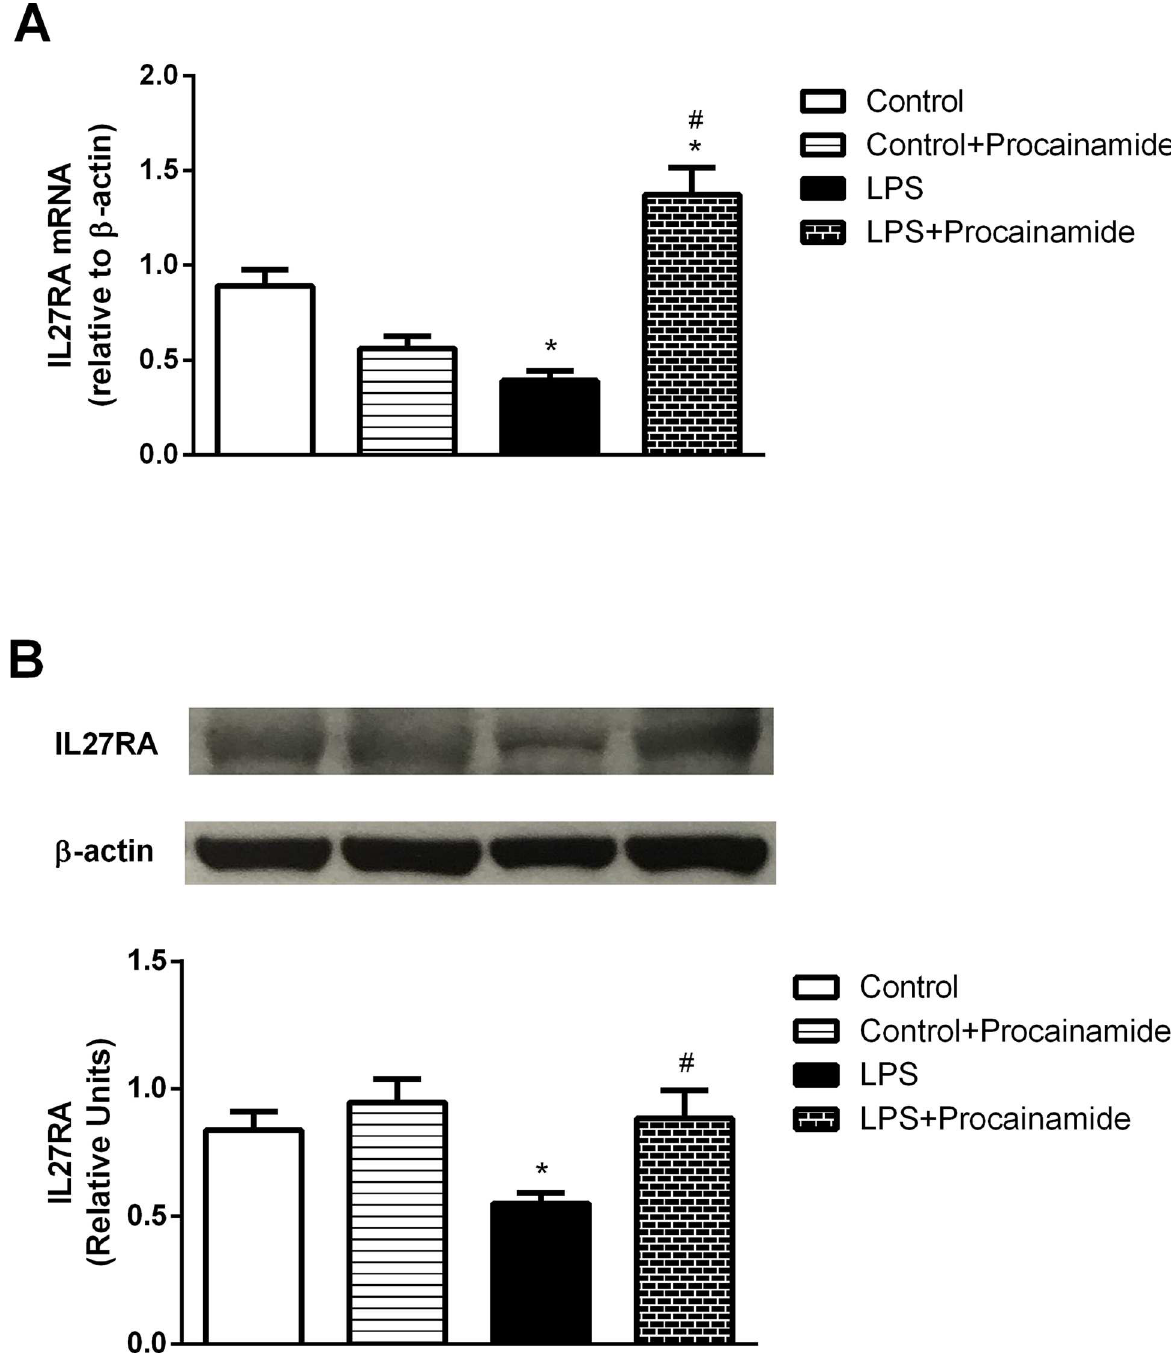
Fig 13. Effectsof procainamide on the expressionsof (A) IL27RA mRNA and (B) IL27RA protein in the lungs obtained from different groups of animals. Depictedare changesin lung IL27RAmRNA andproteinexpressionsat the end of experiment (at 6 h) in different groupsof rats that receivedsaline at time 0 (Control,n = 4), receivedsalineas in Controlgroup and then receivedprocainamide at 1 h (Control + Procainamide, n = 4), receivedLPS at time 0 (LPS, n = 4), and receivedLPS at time 0 andthen receivedprocainamide at 1 h (LPS + Procainamide, n = 4). Data are expressed as mean ± SEM. * P < 0.05, all versus Controlrats; # P < 0.05, with versus without procainamidein LPS rats